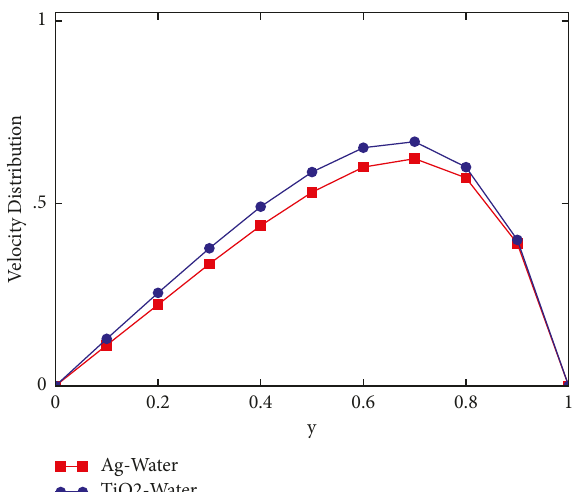
Figure 6: Correlation between nanofluid for velocity, when Pr